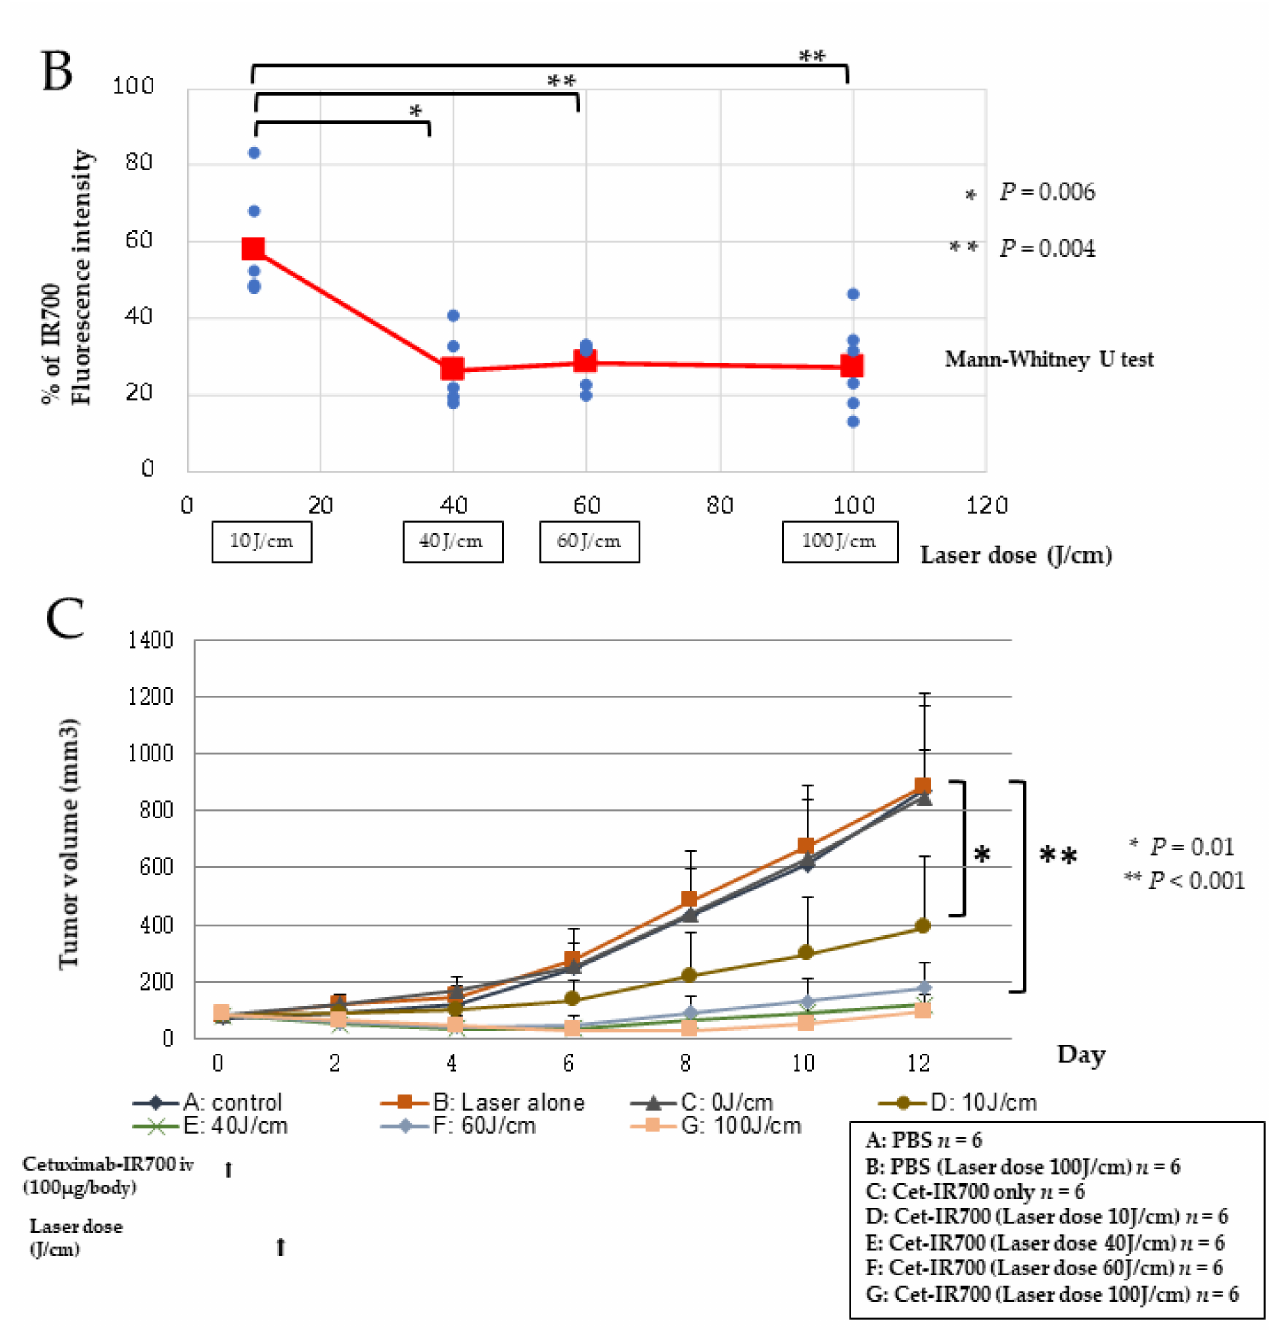
Figure 4. Relationship between laser dose and antitumor effect. ( A ) The fluorescence intensity at the beginning of treatment was examined in each laser dose group (10, 40, 60, 100 J/cm). ( B ) The rate of fluorescence intensity decay at the end of irradiation was examined in each laser dose group (10, 40, 60, 100 J/cm). ( C ) Volumes of A431 tumors were compared among the groups treated with Cet-IR700 and irradiated with various laser doses (10, 40, 60, and 100 J/cm) and the untreated control group. Data are shown as mean values ( n = 6 per group, 12 days after initial treatment, dots are mean values, bars are